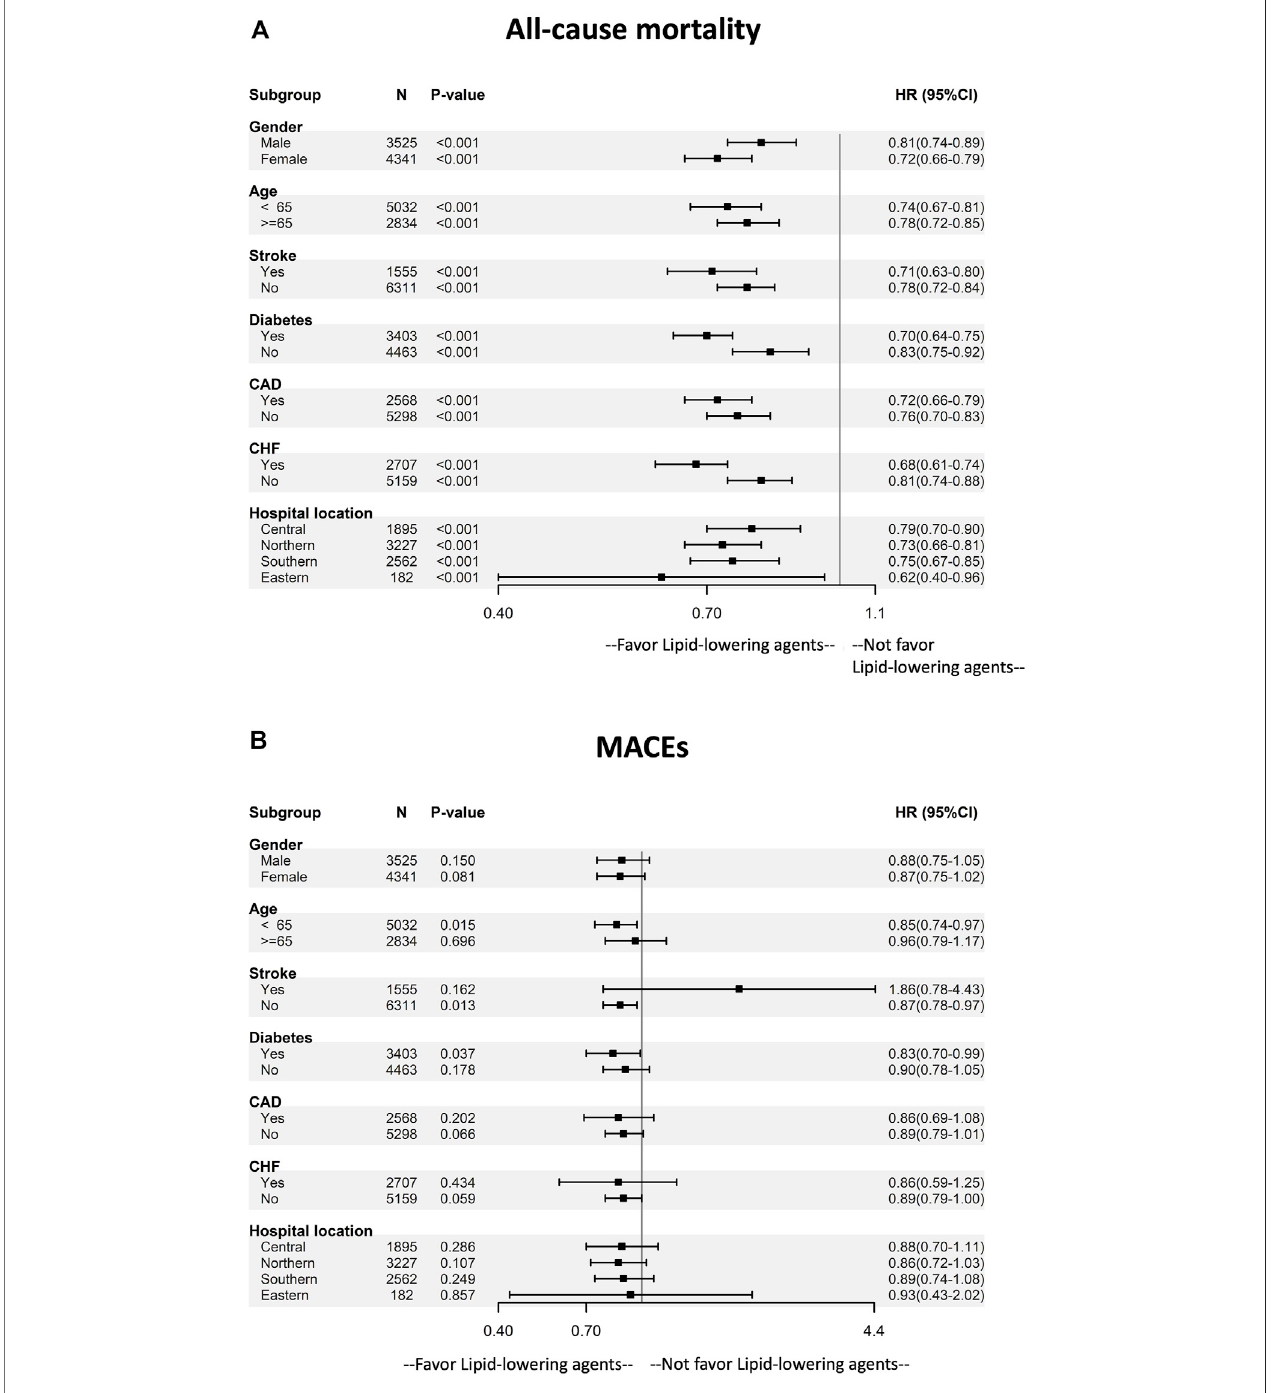
FIGURE 3 | Subgroup analysis of the effect of lipid-lowering agents use on (A) mortality and (B) MACEs by baseline characteristics. The multivariable adjusting model was the same asmodel 2 in Table 2 . Abbreviation: CAD, coronary arterydisease; CHF, congestive heart disease; MACEs, major adverse cardiovascular events.